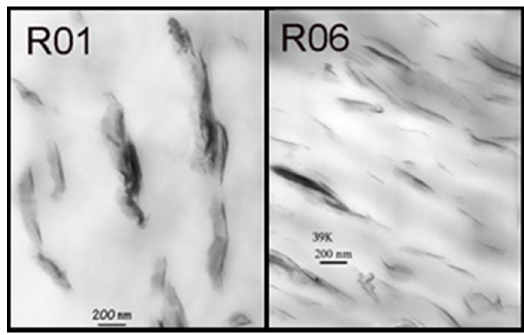
Figure 5. TEM-images for Run 1 (R01) and Run 6 (R06) [21].